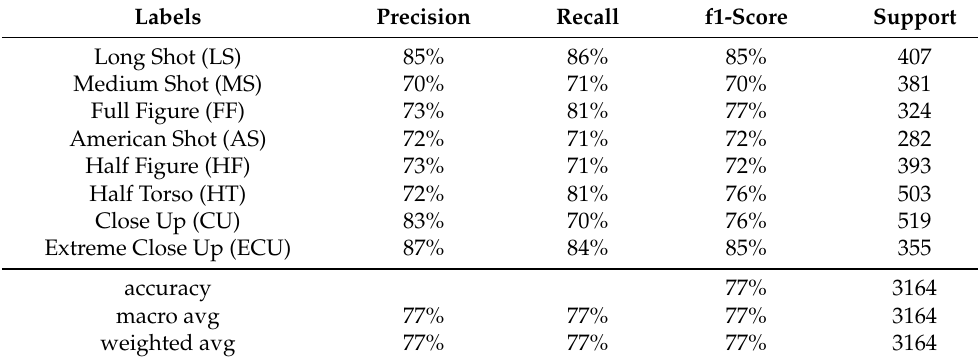
Table 11. Precision recall and f1-score of a VGG-16 trained on the augmented Original Dataset with the flip on the y-axis and zoom range = 0.1, i.e., Scenario